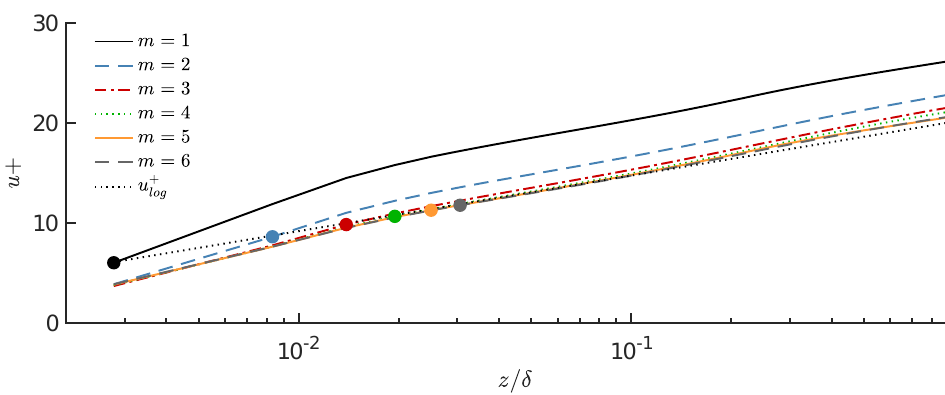
Figure 1. Non − dimensional mean axial velocity u + as function of normalized wall distance z / δ computed using the m -th grid point off the wall, indicated by colored dots as denoted in the legend. The black dashed straight line marks the logarithmic law for a rough wall with δ / z 0 = 4500. + The non-dimensional axial turbulence intensity u (cid:48) u (cid:48) , shown in Figure 2a, exhibits a similar behavior as the normalized velocity distribution u + . For z > 0.01 δ , the profiles converge with increasing m and become indistinguishable for m ≥ 3. The normalized wall- + + + normal and lateral intensities v (cid:48) v (cid:48) , w (cid:48) w (cid:48) and u (cid:48) w (cid:48) , shown in Figure 2b–d, however, are even less sensitive and are indistinguishable for z > 0.03 δ disregarding the choice of m . In the region z < 0.01 δ , the variation of m has a more significant effect. All intensities increase with increasing m , whereas they also seem to converge for m ≥ 5. Hence, considering